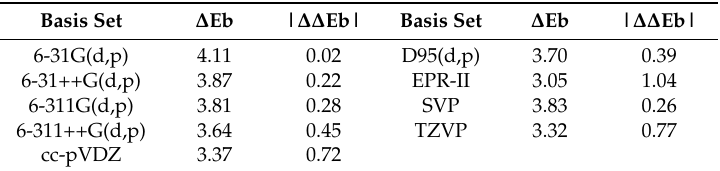
Table 1. MP4(SDTQ)/(basis set)//B3LYP/6-31G(d,p) calculations based on malonaldehyde transition state. ∆ Eb is the barrier height (in kcal/mol). | ∆∆ Eb| is the absolute difference with respect to the reference value (4.09 kcal/mol).